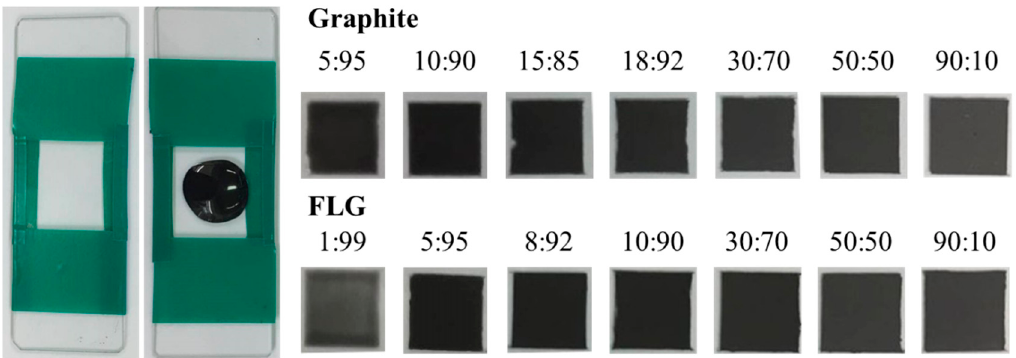
Figure 2. Photo images of graphite/PVDF and FLG/PVDF composites.